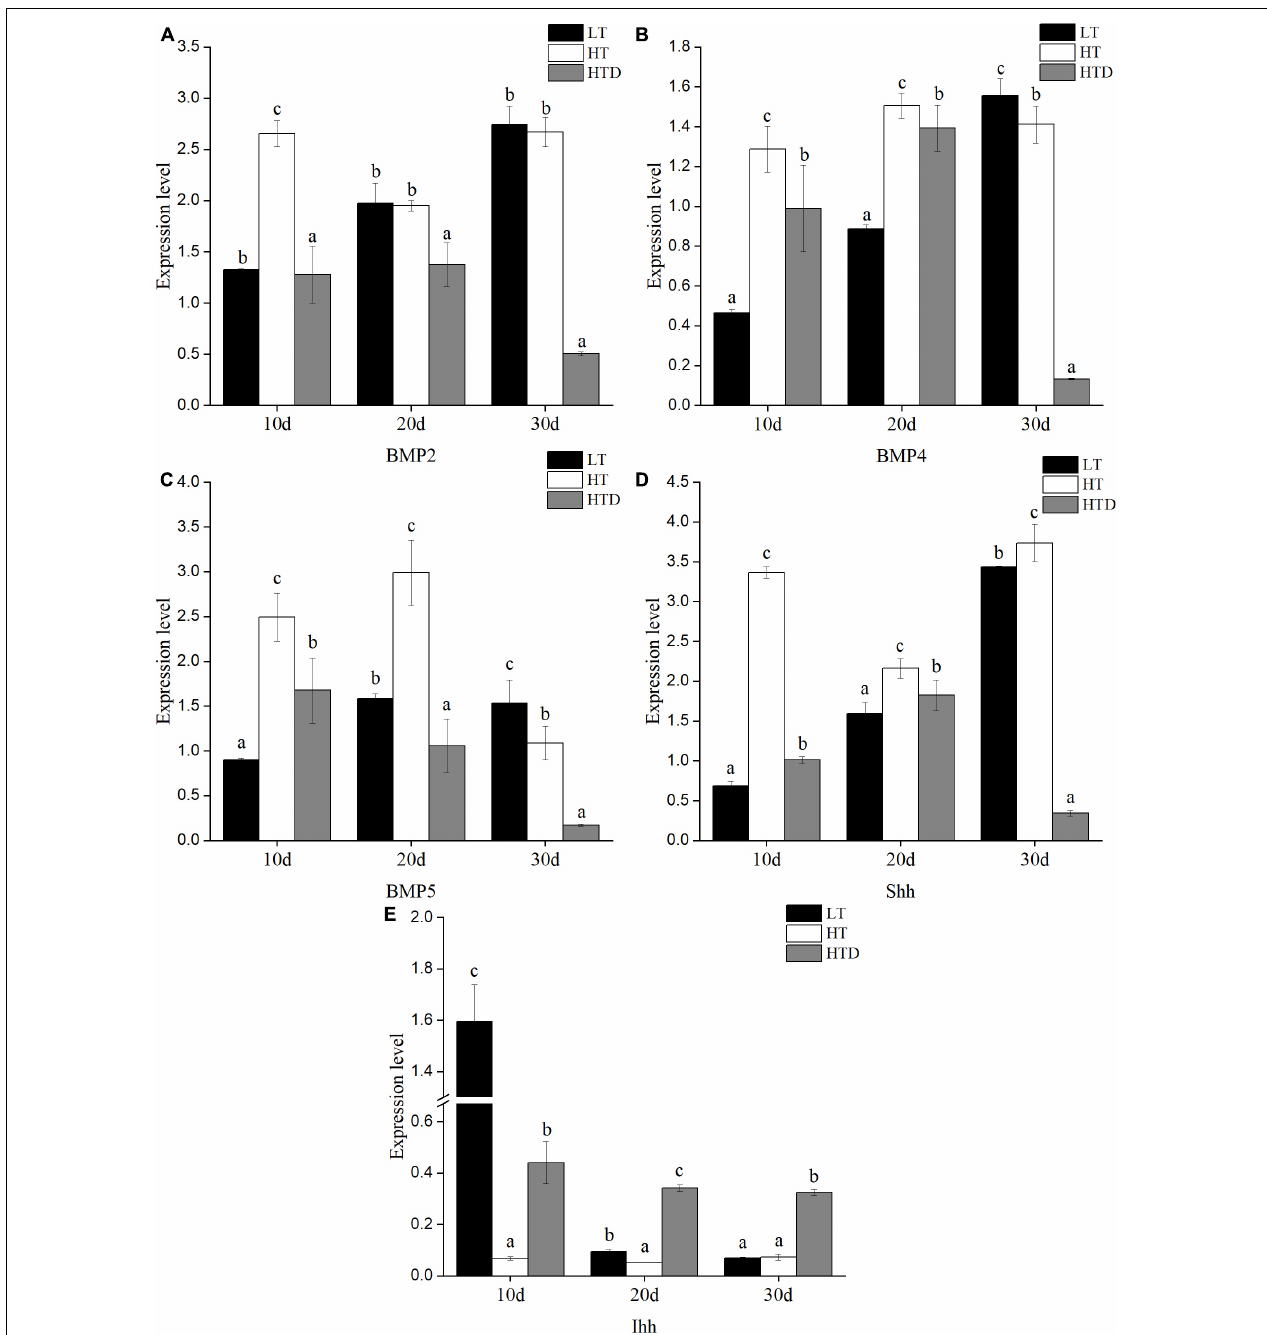
FIGURE 6 | The expression levels of signaling molecules ( A : BMP2, B : BMP4, C : BMP5, D : Shh, E : Ihh) in the spine of juvenile T. ovatus (LT, low temperature group; HT, high temperature group; HTD, high temperature deformity group).